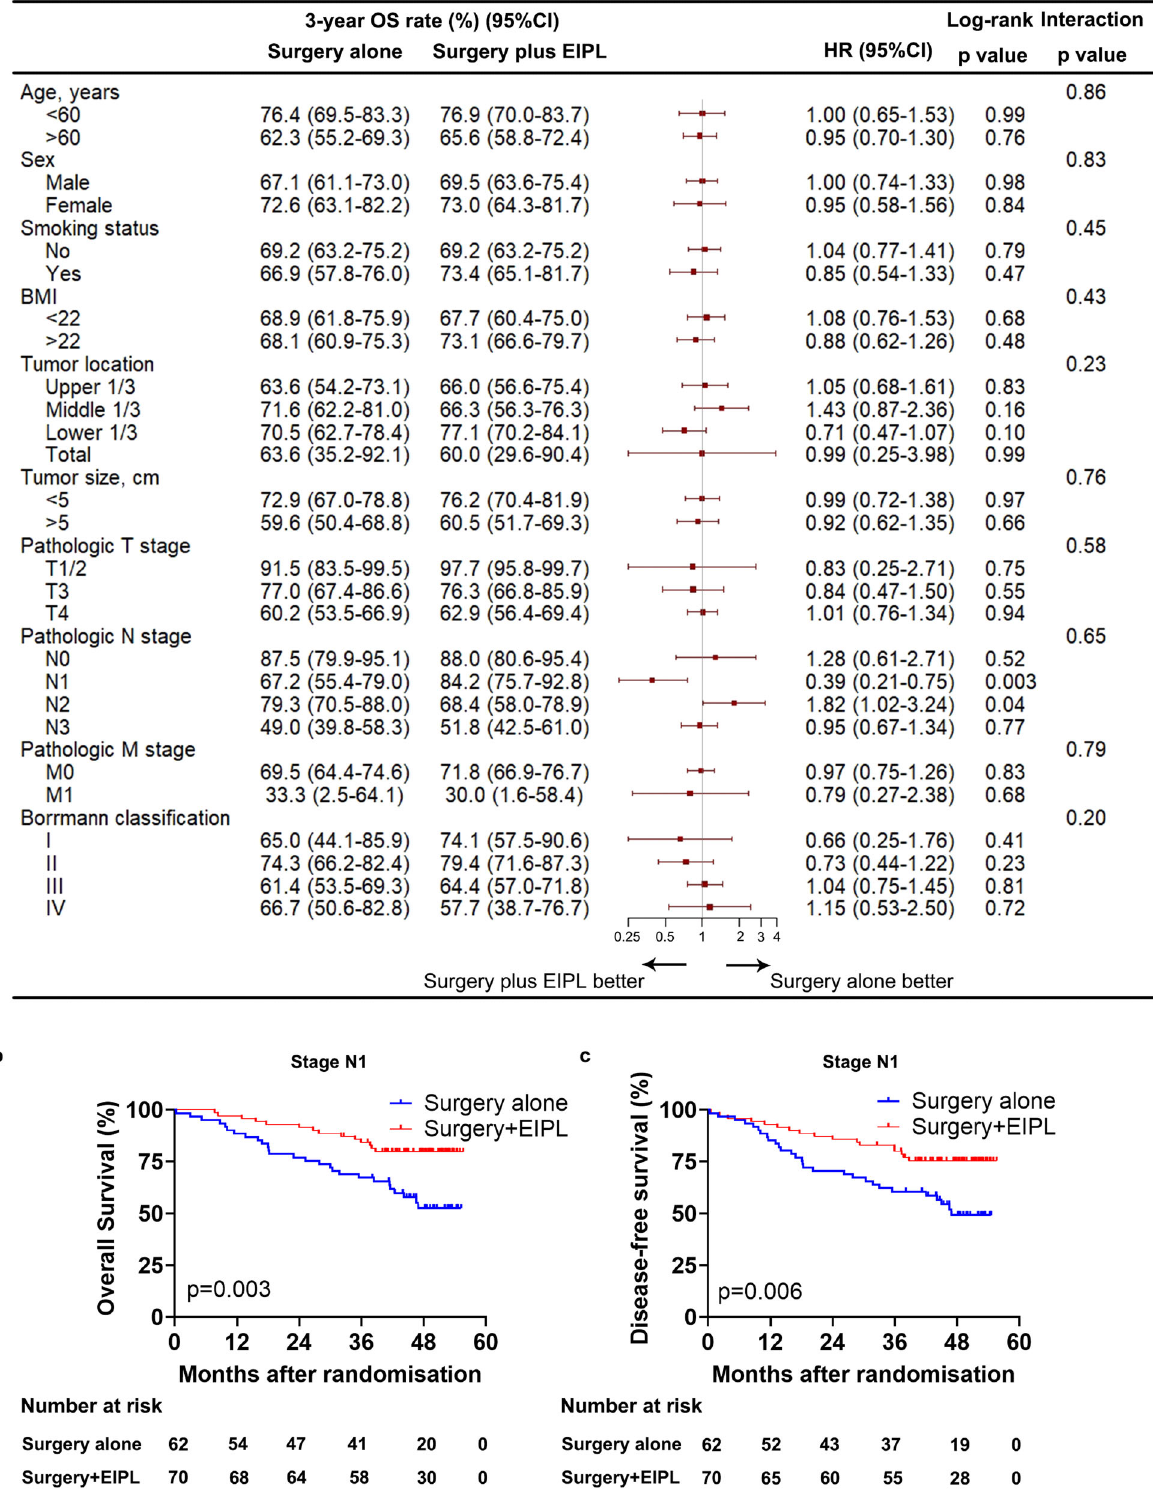
NATURE COMMUNICATIONS| (2021) 12:6598